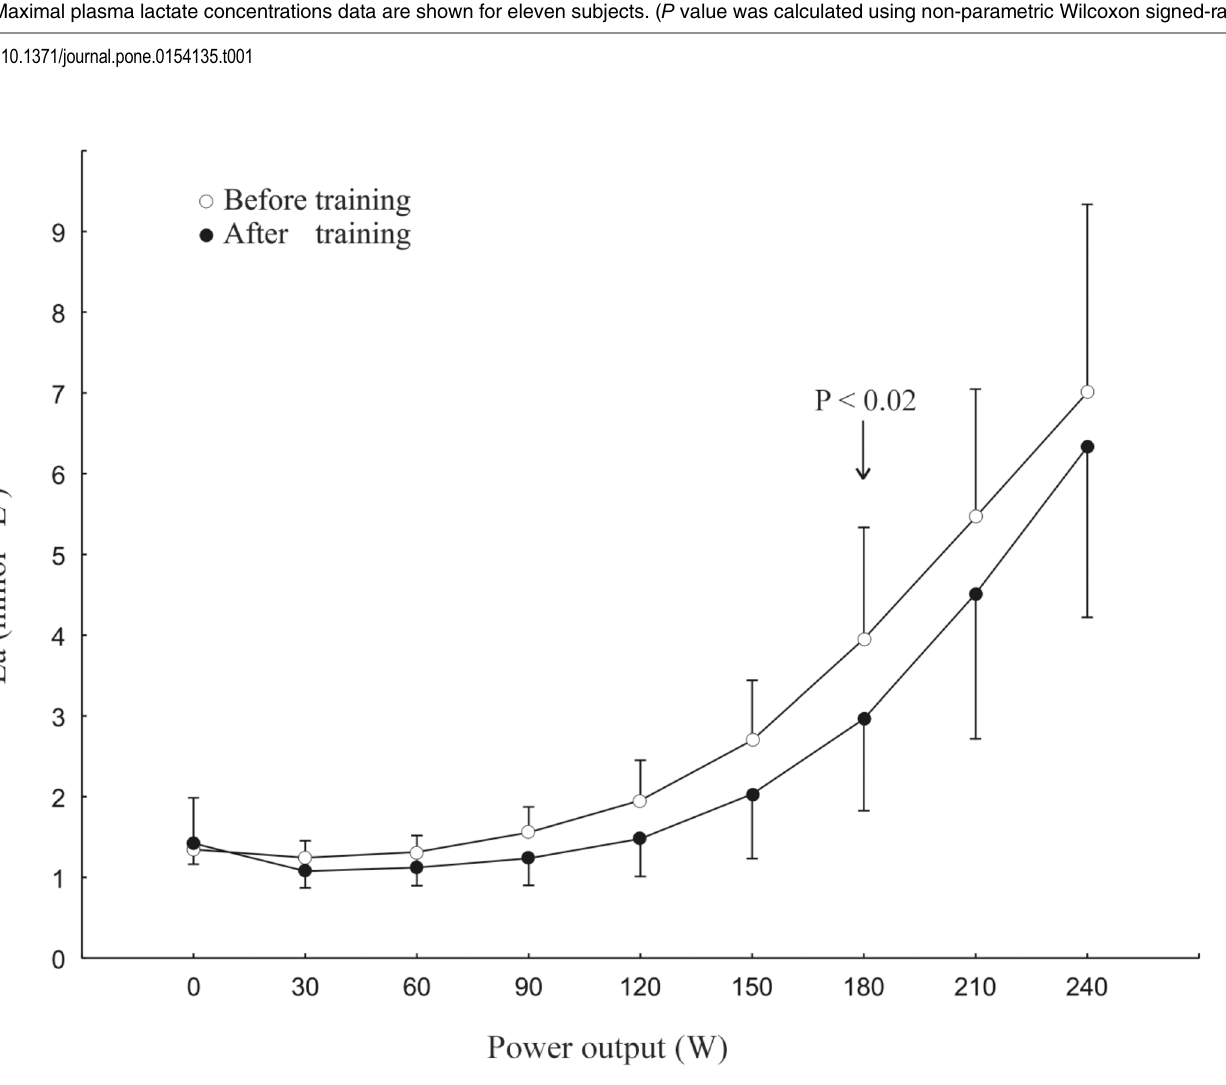
Fig 3. Plasma lactate concentration [La - ] pl during an incremental exercise test before (white circles) and after (black circles) 20 weeks of endurance training. The power output was increased by 30 W every 3 minutes up to 240 W. Note the right-ward shift of the lactate curve after training and especially the difference ( P < 0.02 Wilcoxon signed rank test) between [La - ] pl at 180 W i.e. near to the power output at which the V ’ O 2 on-kinetics has been determined, before and after the training. Data are given as means ± SD for 11